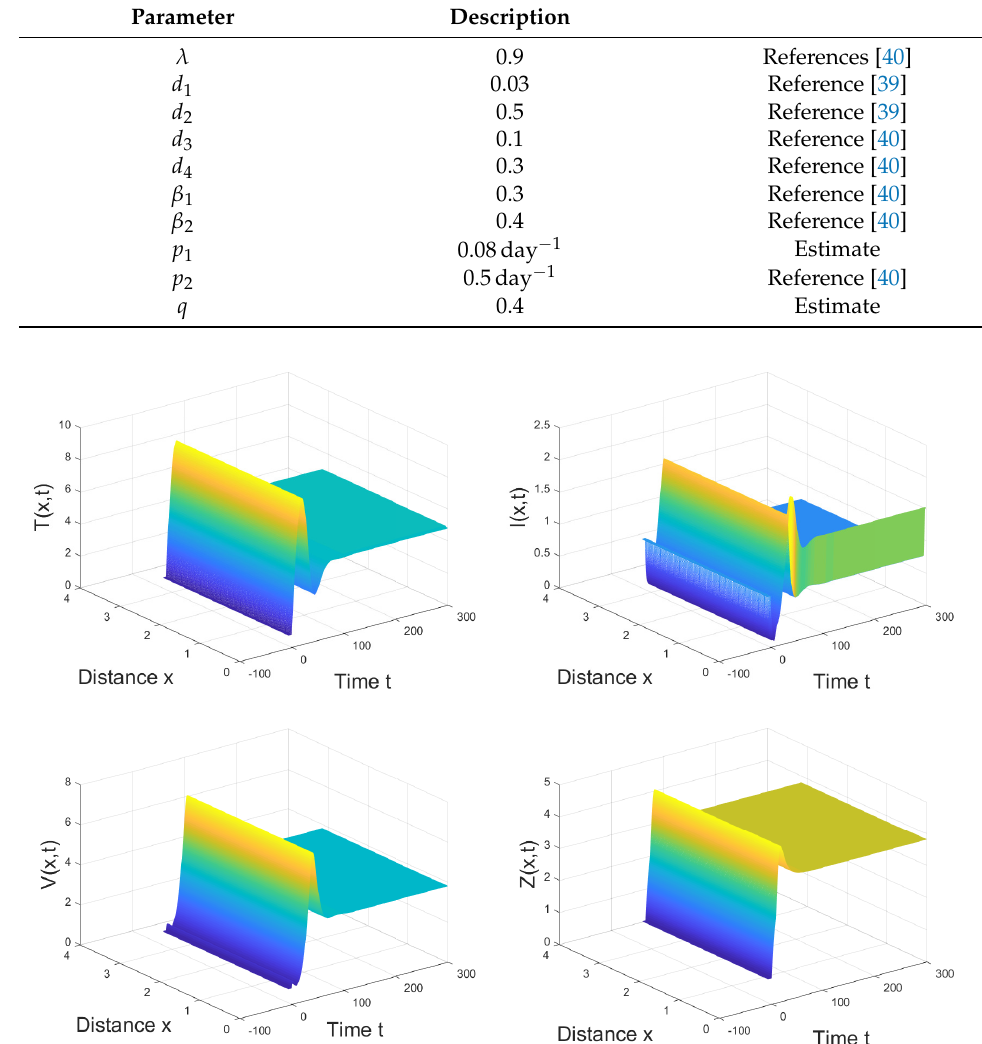
Table 1. State variables and parameters of HIV-1 infection model.